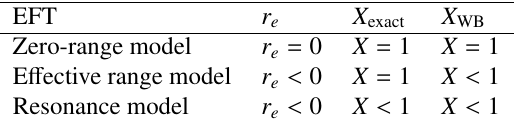
Table 1. Summary of the e ff ective range r e , the exact value of the compositeness X exact , and X WB determined by the weak-binding relation (1) in the e ff ective field theories in the zero range